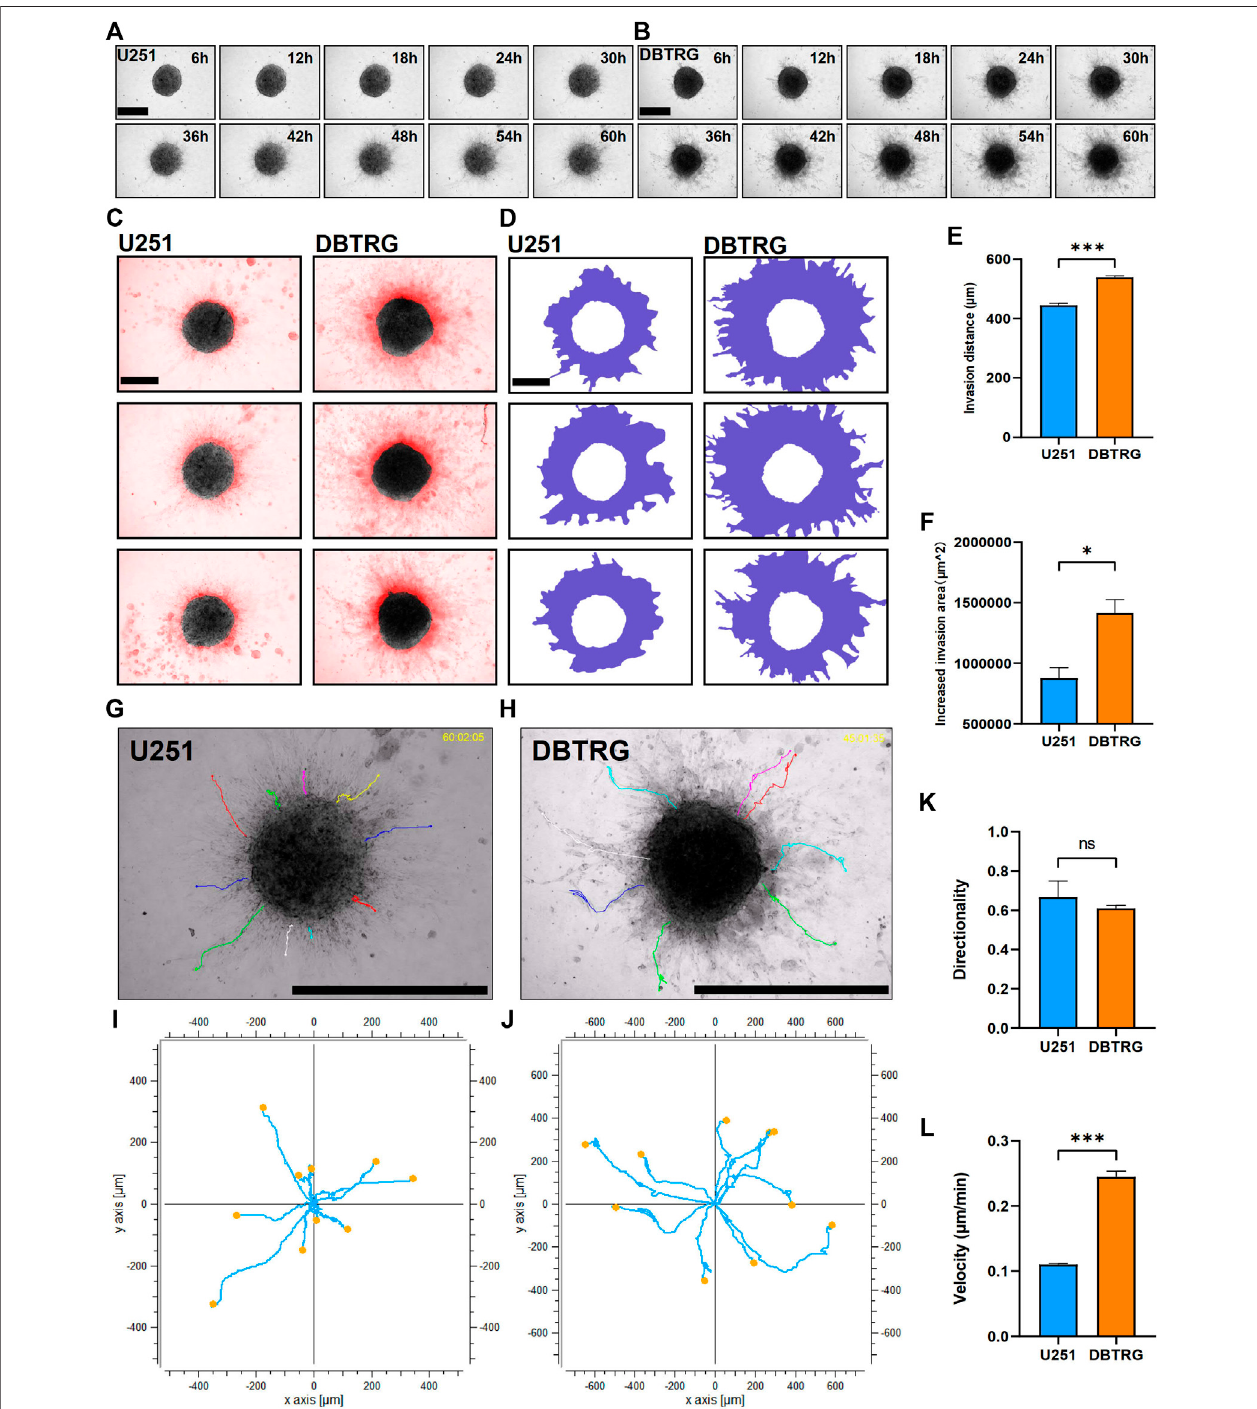
FIGURE 2 | Quantitative invasion analysis of DBTRG and U251 spheroid in 0.5 mg/ml Collagen Ⅰ + 3 mg/ml Matrigel. (A,B) Representative images of U251 and DBTRG spheroids in 0.5 mg/ml Collagen Ⅰ + 3 mg/ml Matrigel over a 60-h period. Scale bar = 600 µm. (C) Invasion of U251 and DBTRG tumor multicellular spheroids in 0.5 mg/ml Collagen Ⅰ + 3 mg/ml Matrigel for 60 h. The black color is the distribution of the tumor multicellular spheroid at 0 h, and the red color indicates the distribution of the tumor multicellular spheroid at 60 h minus that of 0 h. Scale bar = 400 µm. (D) Invasion area (purple area) of U251 and DBTRG spheroids within 60 h in 0.5 mg/ml Collagen Ⅰ + 3 mg/ml Matrigel. Scale bar = 400 µm. Statistical data show the difference of invasion distance (E) and invasion area (F) between the U251 and DBTRG spheroids. (G,H) The mergedimageofsinglecelltrajectoryandspheroid.Scalebar=1000 µm. (I,J) TrajectoryofrepresentativesinglecellsintheU251andDBTRGspheroids.Statisticaldatashowthe difference of invasion directionality (K) and invasion velocity (L) between the cells of U251 and DBTRG spheroids. * p < 0.05, *** p < 0.001, ns: no signi fi cance.